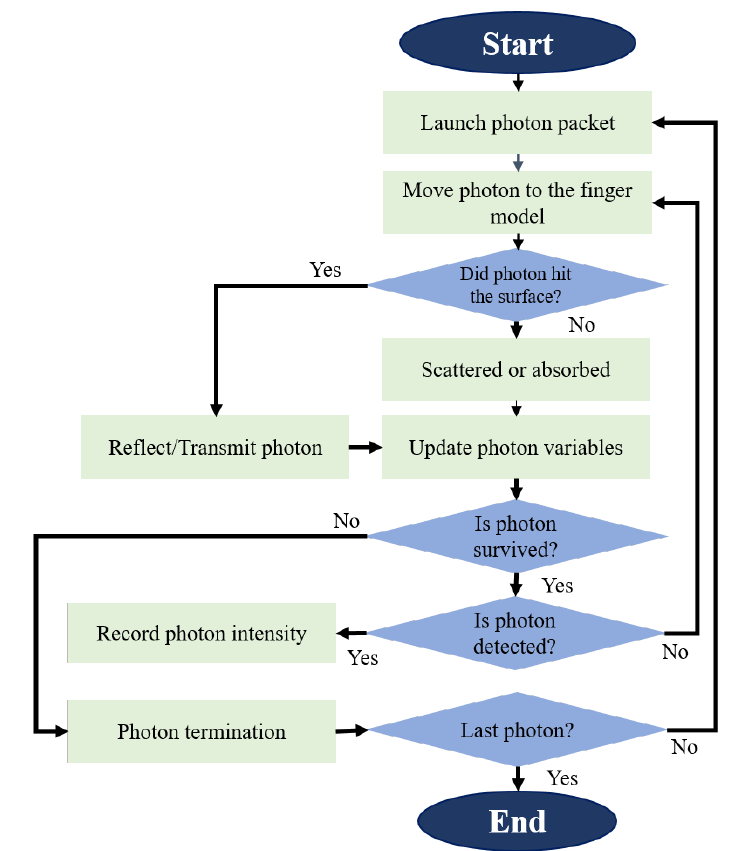
Figure 5. Flowchart of the MCS in this study.